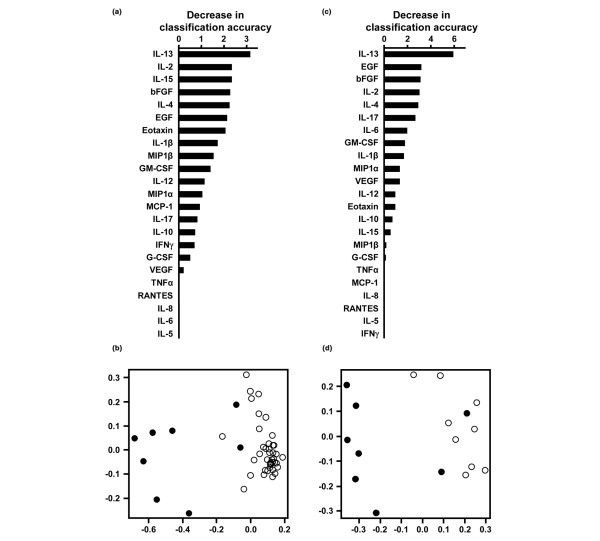
Importance of individual cytokines in classifying patient groups. Plots represent models discriminating patients with early inflammatory arthritis who develop rheumatoid arthritis (RA) from (a,b) all other early inflammatory arthritis patients (early disease that progresses to non-rheumatoid persistent disease plus early non-crystal-related resolving arthritis plus crystal-related resolving arthritis) and from (c,d) established RA. Panels a and c show the relative importance of the cytokines in the overall classification. The vertical axes represent individual cytokines arranged according to importance. The horizontal axes represent the average decrease in classification accuracy seen when the values for each cytokine are permuted. Important cytokines are associated with a greater decrease in classification accuracy. The plots shown in panels b and d are metric multidimensional scaling (MDS) representations of the proximity matrices of the Random Forest models demonstrating the relationship between individual patients in the two models. The two axes represent the first and second MDS axes. Closed circles represent patients with early inflammatory arthritis who develop RA in both panels; open circles represent patients with (panel b) all other early inflammatory arthritis and (panel d) established RA.